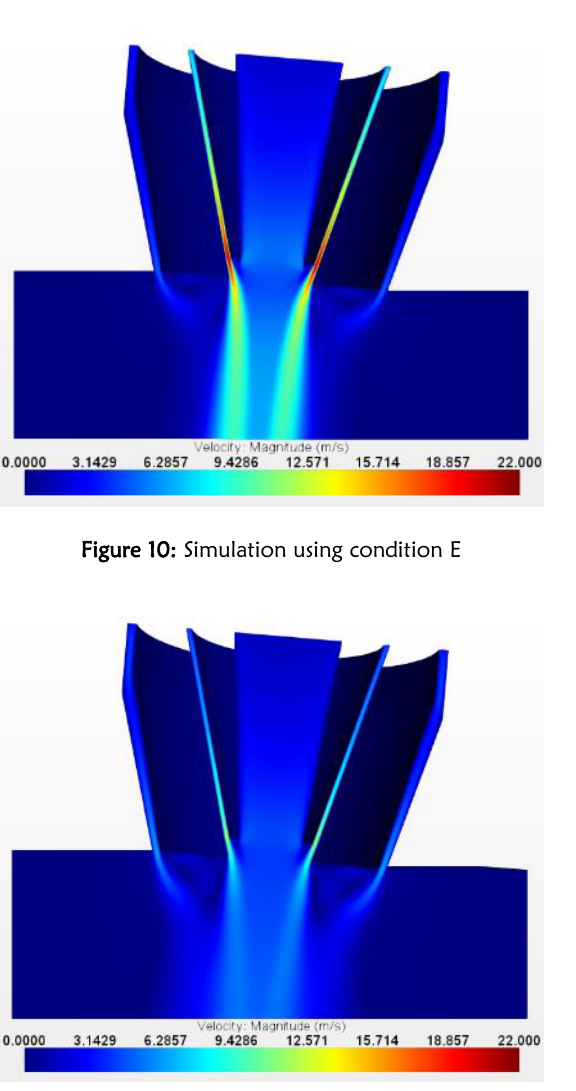
Figure 11: Simulation using condition